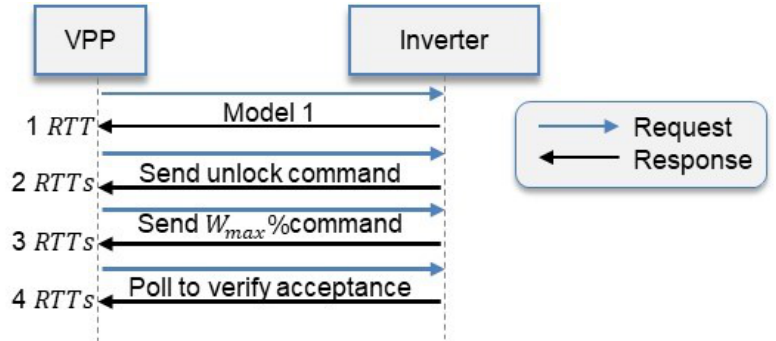
Figure 10. Sequence of messages associated with limiting power.